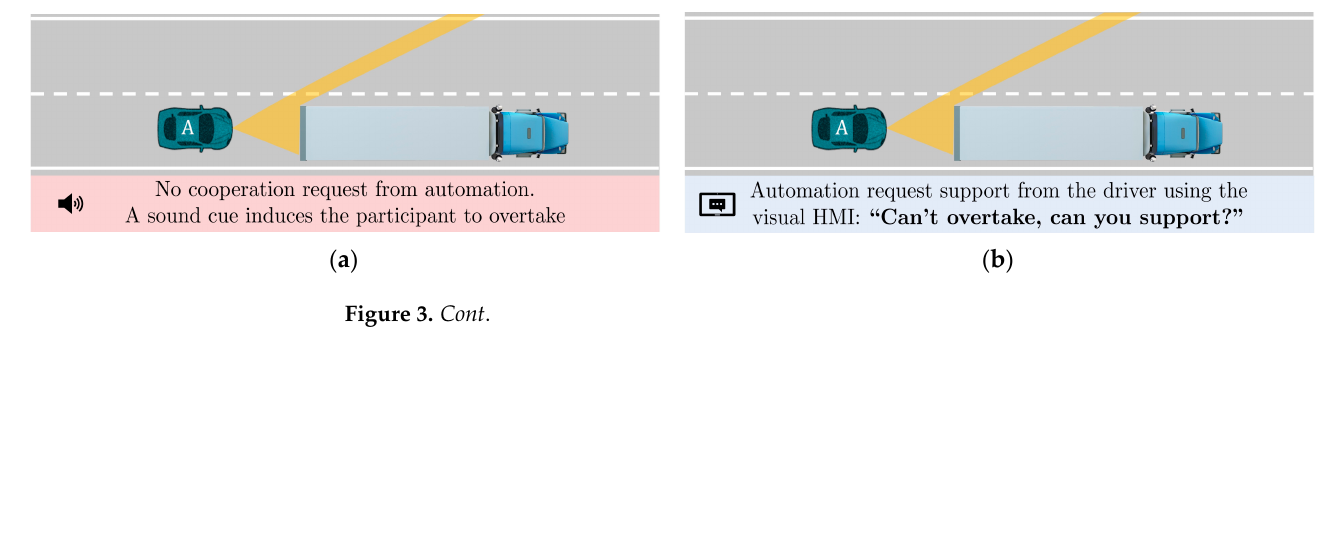
Figure 2. DiL simulator for AD applications with Dynacar vehicle simulation software in screens, and Re:Lab HMI as the instrument